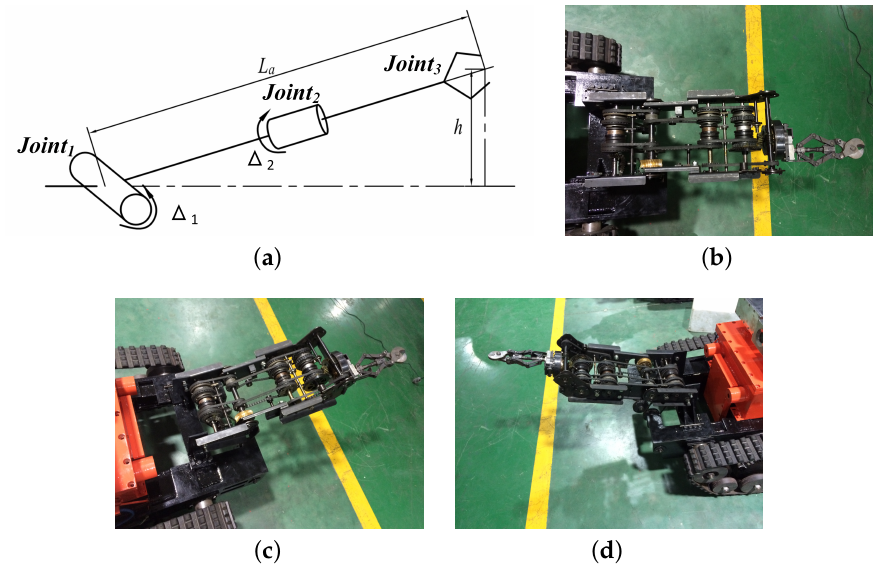
Figure 18. In figure ( a ), Joint 1 represents the shoulder joint; Joint 2 represents the wrist joint; and Joint 3 represents the scissors joint. ∆ 1 and ∆ 2 represent the rotation angle of the shoulder and wrist joints, respectively; h represents the current height of the scissors; La represents the length of the manipulator; the length of the prototype is 0.664 m. ( b – c ) show the manipulator prototype. ( d ) Left view of the manipulator prototype.